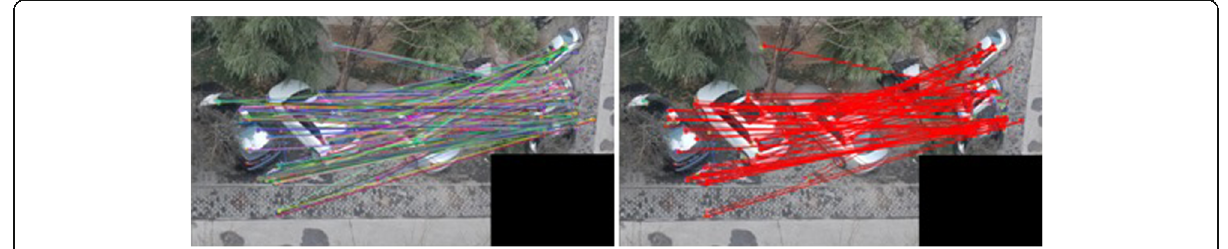
Fig. 25 Result graph of ORB algorithm in image detection of different